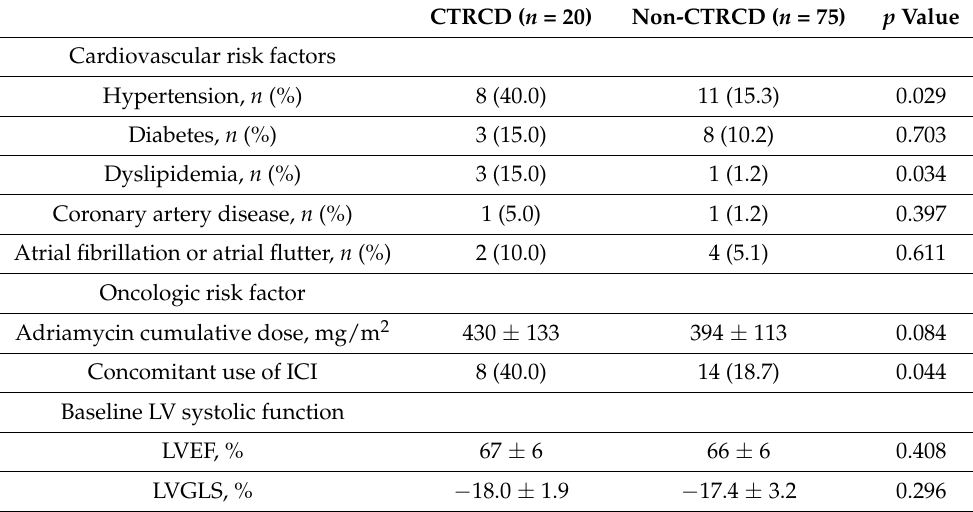
Table 3. Comparison between CTRCD and